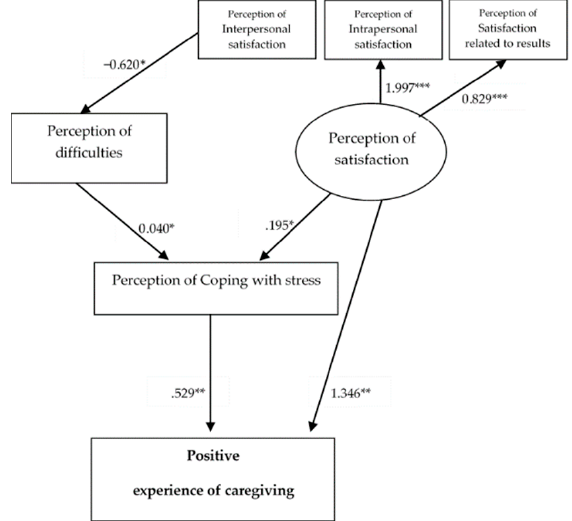
Figure 4. Standardized solutions of the accepted M3 model. Note: Only considered the significant estimates of regressive coefficients. * p < 0.05; ** p < 0.01; *** p < 0.001.